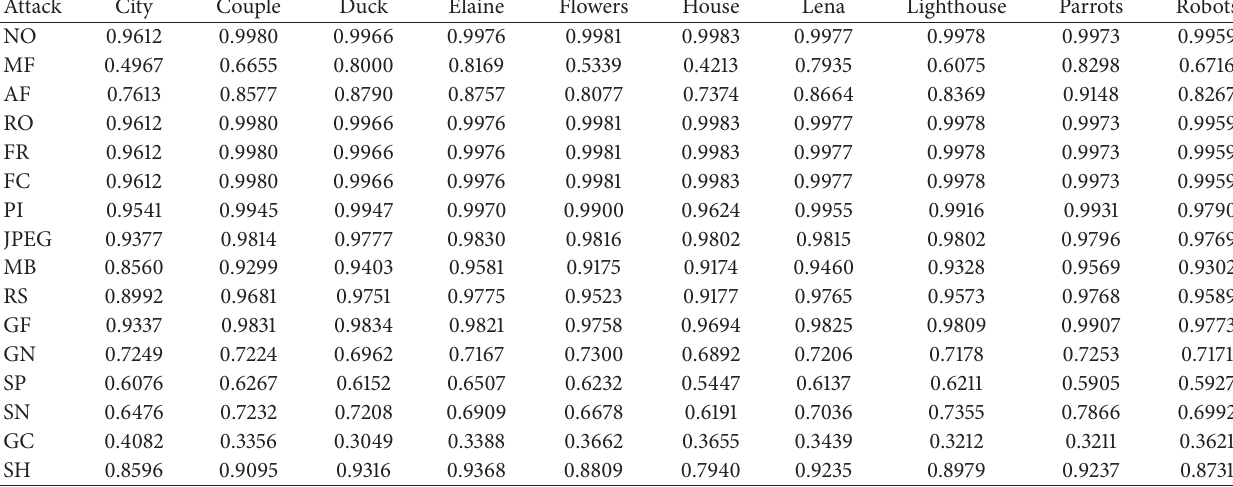
Table 4: Correlation values of the extracted watermarks by the proposed scheme corresponding to